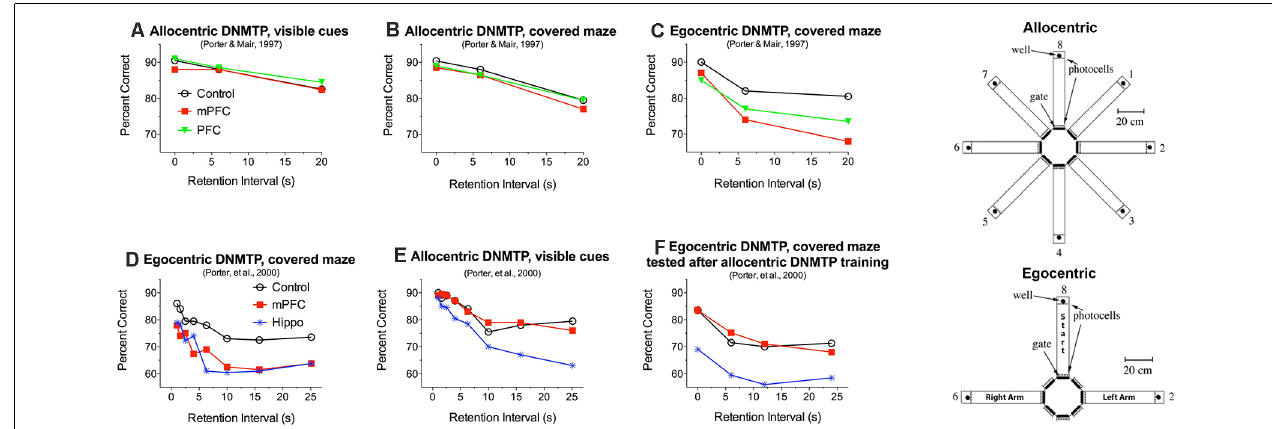
FIGURE 2 | Effects of medial prefrontal (mPFC), complete prefrontal (PFC), and hippocampal (Hippo) lesions on allocentric and egocentric versions of 2-choice DNMTP trained in eight arm radial mazes. Samples and choices in egocentric DNMTP were between the same two arms on every trial, located to the left and right of the holding arm. Arms for allocentric DNMTP were selected at random on every trial from the eight alternatives so that their configurations were unpredictable. For egocentric DNMTP external cues were minimized by covering mazes and training in the dark, while allocentric DNMTP was trained in uncovered mazes with lights on and many visible external cues. mPFC and PFC lesions impaired egocentric (C,D) and spared allocentric DNMTP (A,B,E) while hippocampal lesions impaired both tasks (D,E) . Rats that received extensive allocentric training (30 presurgical and 20 postsurgical sessions) were protected when subsequently switched to egocentric DNMTP (F) . Data are replotted from studies